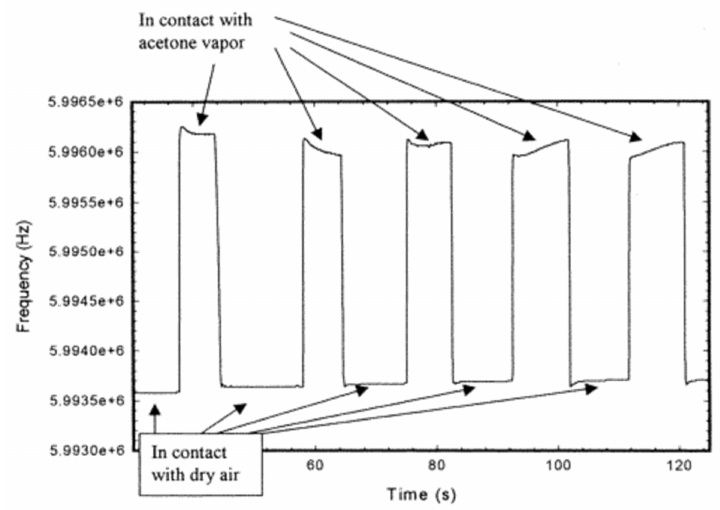
Figure 3. The response of an IL-coated QCM sensor on alternate flushing with saturated acetone vapors and dry air. Figure is reproduced from